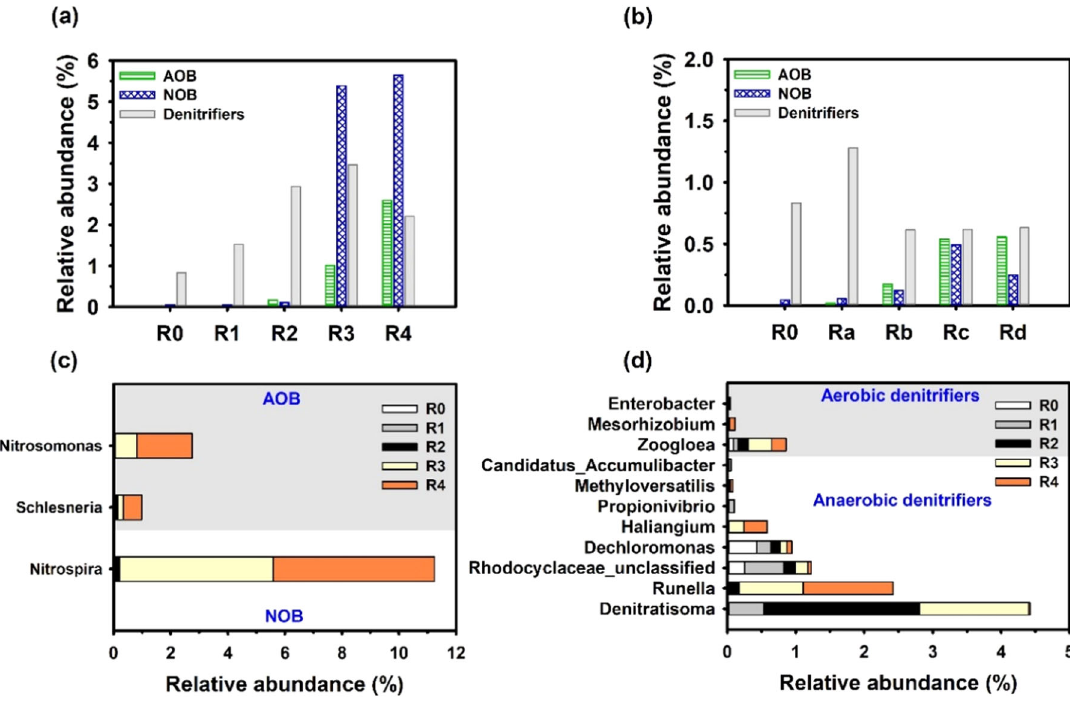
Fig. 6 The relative abundance and composition of the nitrogen utilizers. a Pro fi les between biomass entrapped in the bioplates and b attached bio fi lms on the corresponding bioplates; c The distribution of c nitri fi ers and d denitri fi ers at the genus level in each bioplate; d The distribution of denitri fi ers at the genus level in each bioplate (shown in Fig.